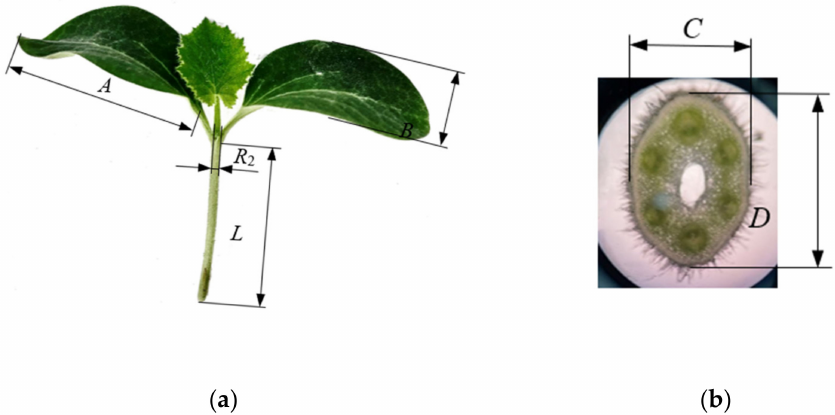
Figure 9. Morphological parameters of the seedlings: ( a ) rootstock seedling and, ( b ) cross-section of the stem. L is seedling height, A is cotyledon length, B is cotyledon width, C is long axis of the stem, D is short axis of the stem, and R 2 is the width of the growing point.